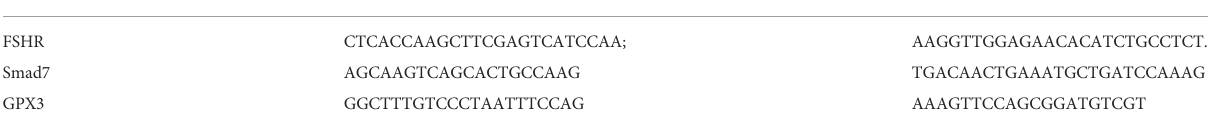
TABLE 1 Primers Tested for RT-PCR of